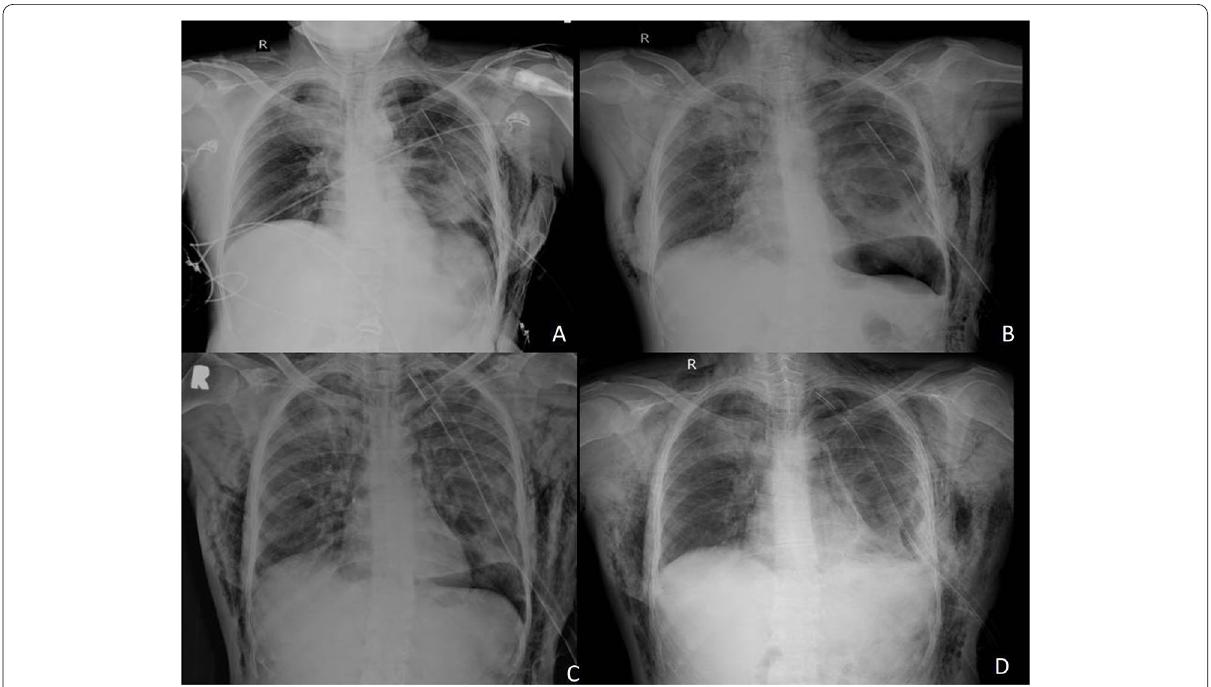
Fig. 2 Posteroanterior radiographs on A day 4 post-surgery, B day 6 post-surgery, C day 7 post-surgery, and D day 8 post-surgery showing progressively worsening subcutaneous emphysema